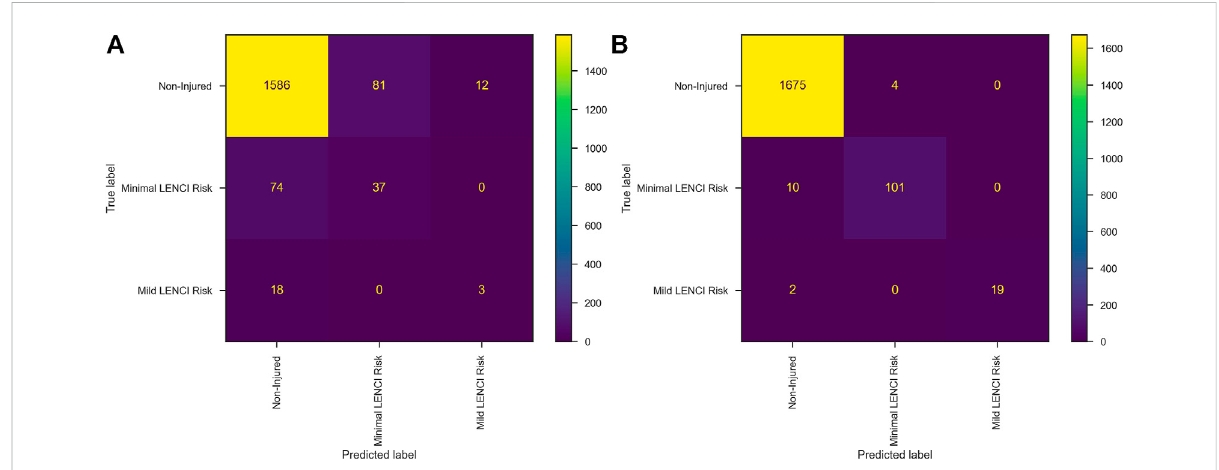
FIGURE 5 Confusion matrix: (A) wFusionModel; (B) dFusionModel.